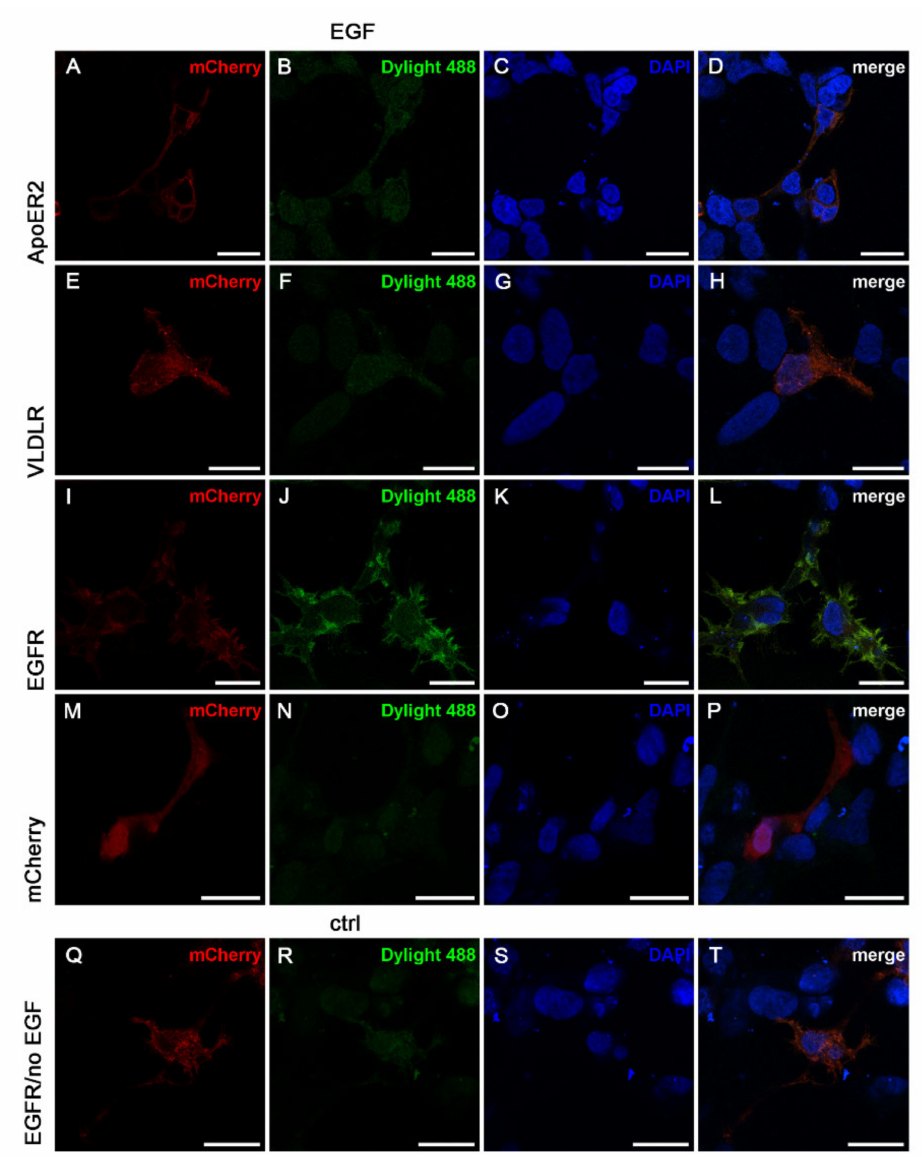
Figure 4. ApoER2 and VLDLR do not bind EGF. HEK293 cells expressing ApoER2_mCherry ( A – D ), VLDLR_mCherry ( E – H ), EGFR_mCherry ( I – L ) or mCherry alone ( M – P ) were incubated with EGF labelled with Dylight488 for 1 min at 37 ◦ C (EGF). In the control condition (ctrl) no EGF was added to EGFR_mCherry expressing cells ( Q – T ). After incubation, cells were fixed, stained with DAPI and mounted. Scale bar represents 20 µ